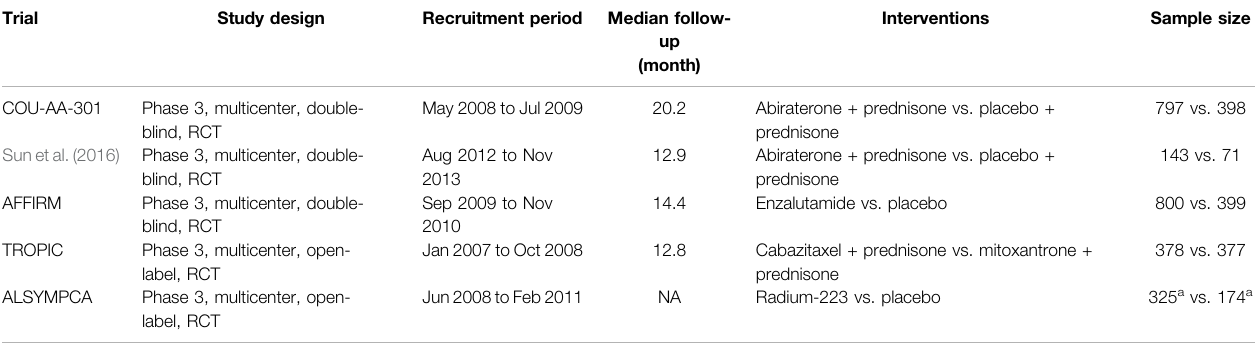
TABLE 1 | Characteristics of included trials.